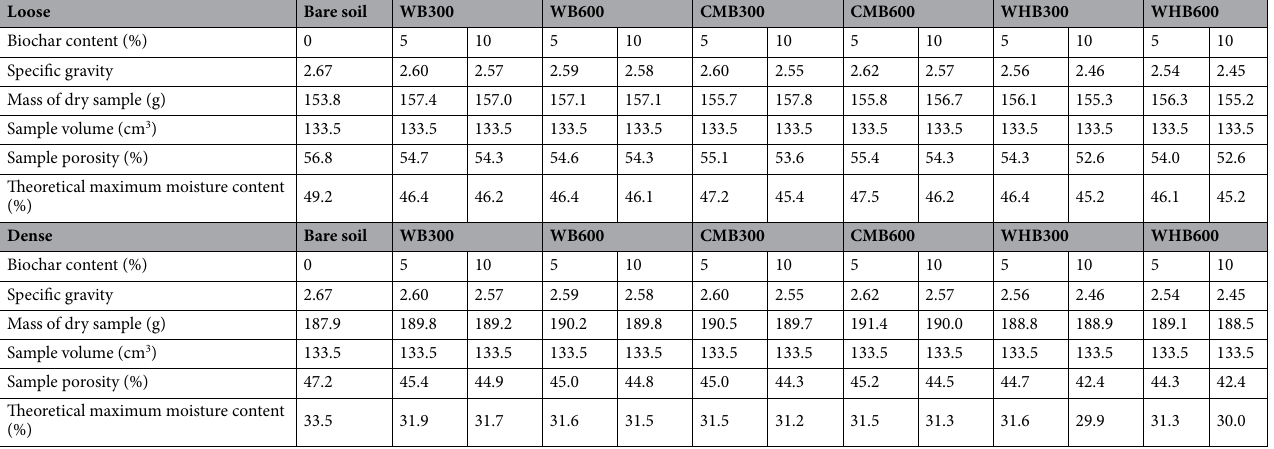
Table 4. Properties of